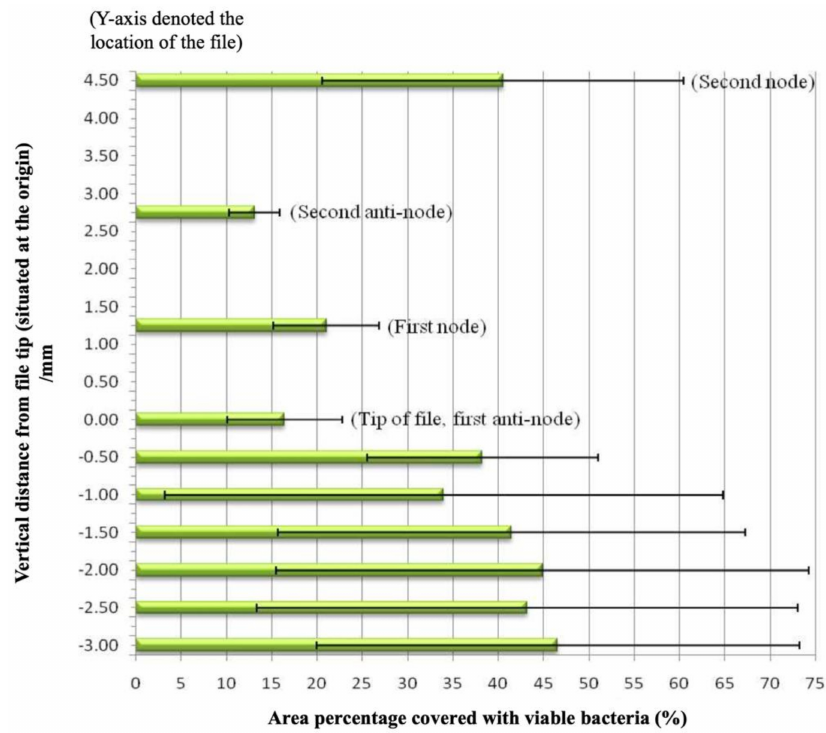
Figure 6. Mean area percentages (and 95% confidence interval) covered by viable bacteria at 4 levels along of the ultrasonic file, and beyond the file